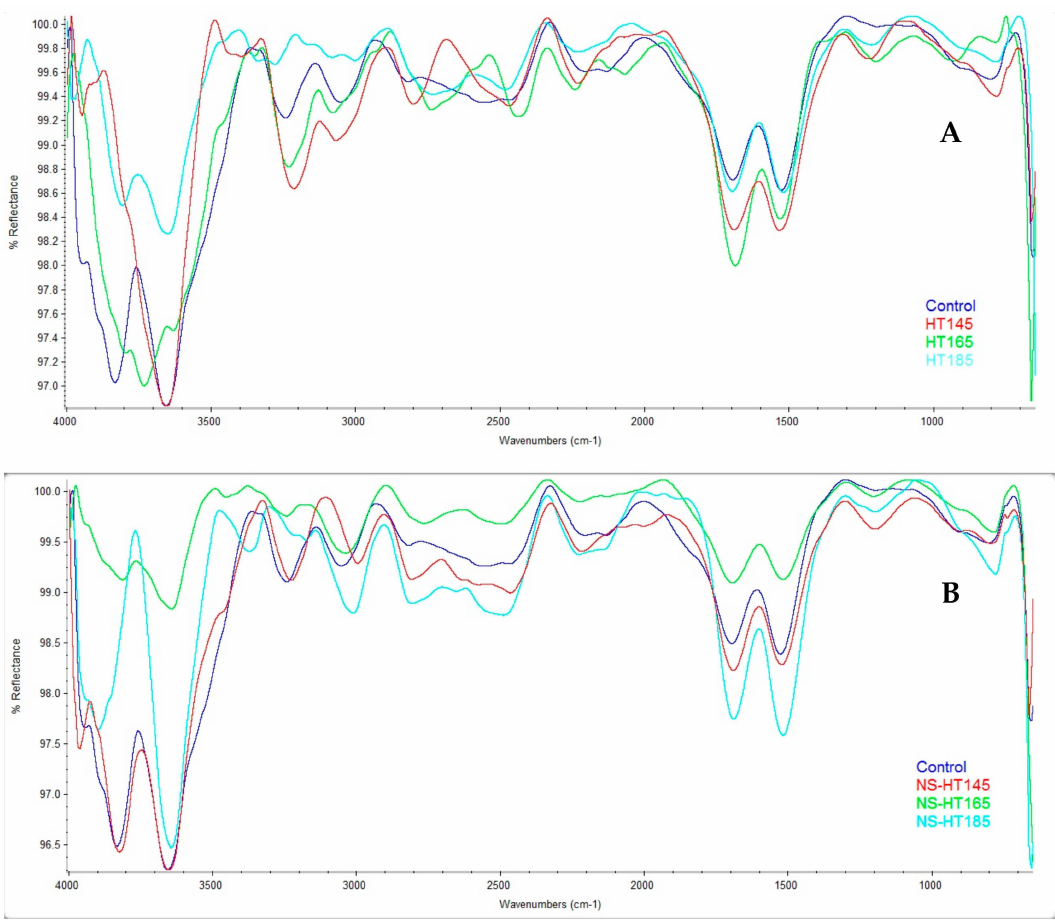
Figure 6. Infrared spectra of the control and thermally-modified ( A ) and the control and nanosilver suspension (NS)-impregnated thermally modified ( B ) beech specimens (HT = heat treatment at a determined temperature; NS = nanosilver